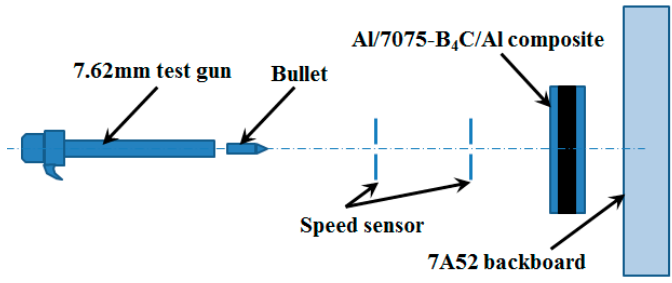
Figure 3. The schematic diagram of the bullet impact test.